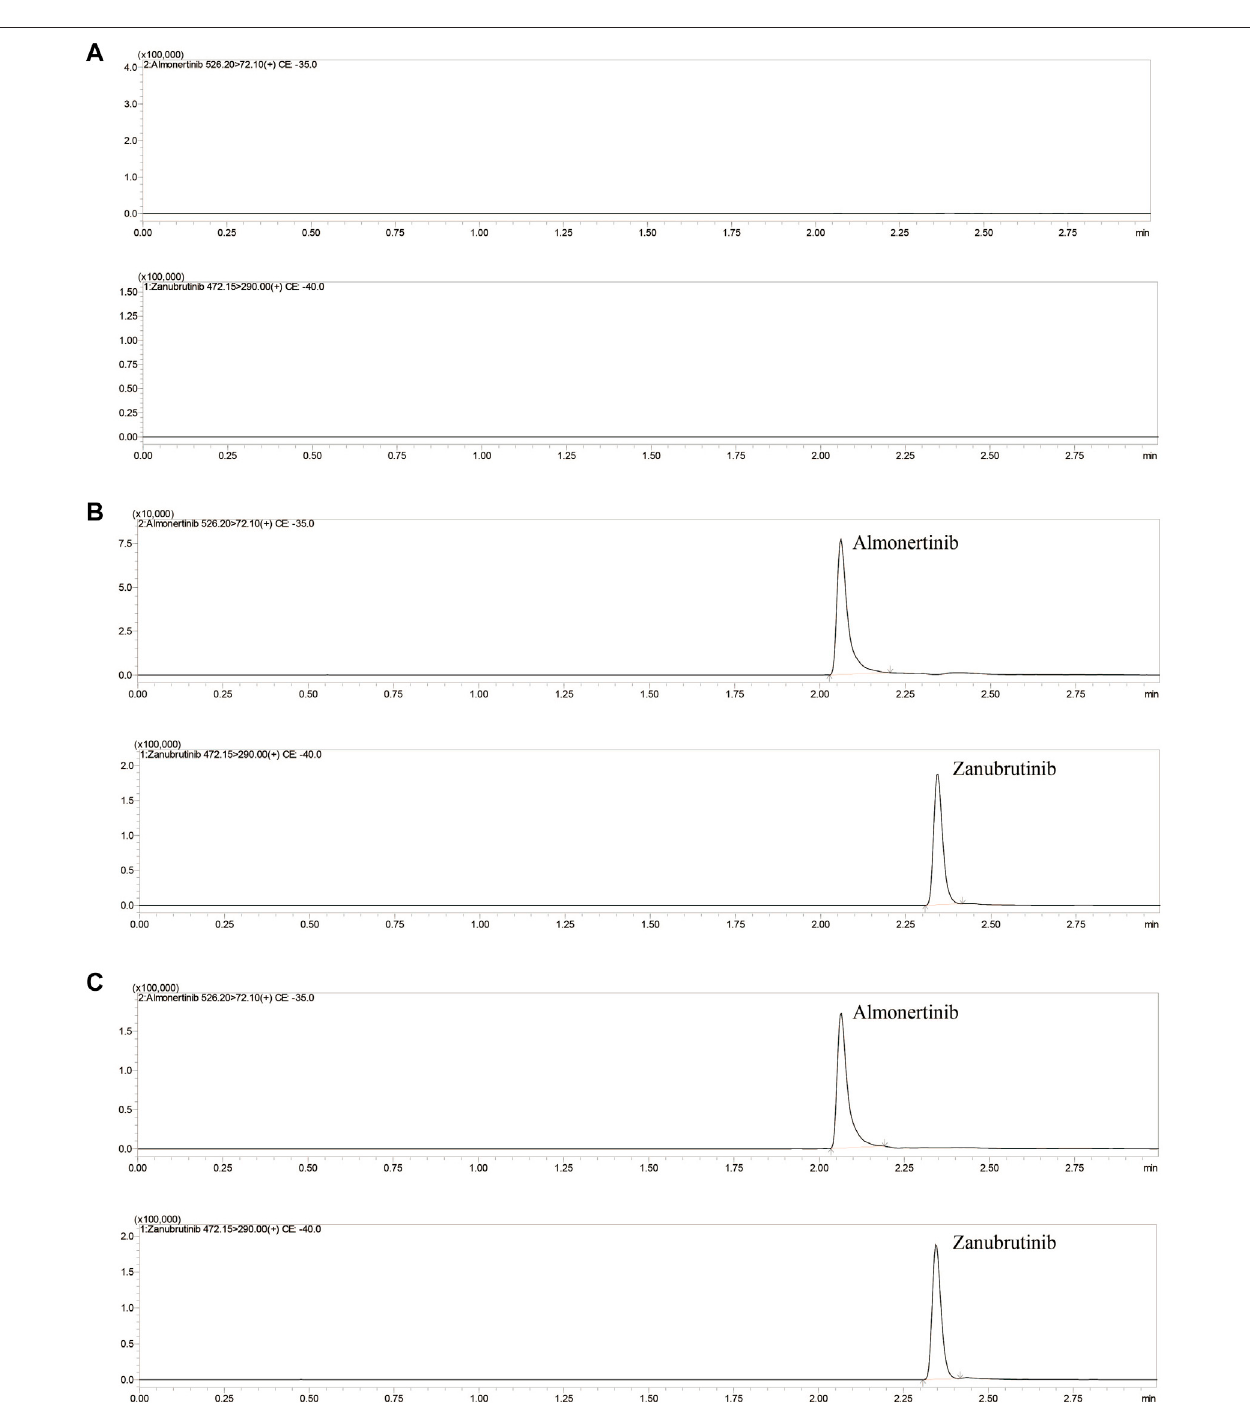
FIGURE 2 | Representative UHPLC – MS/MS chromatograms of almonertinib and zanubrutinib (IS). (A) blank plasma; (B) a blank plasma sample spiked with almonertinib and IS; (C) a rat plasma sample obtained 1 h after oral administration of almonertinib.